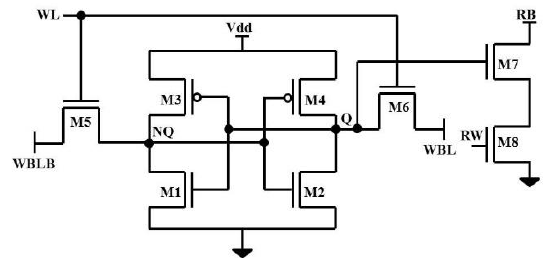
Figure 5. Traditional 8T - SRAM cell.